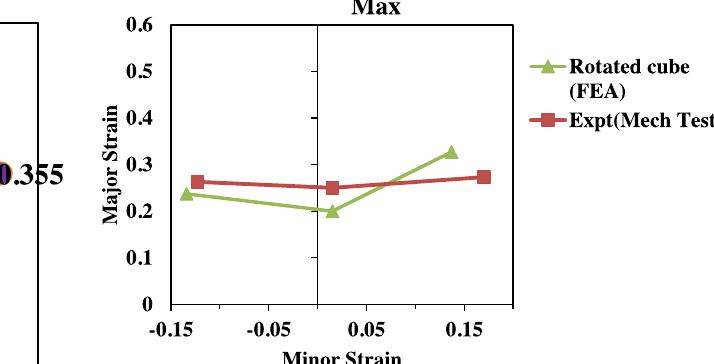
Fig. 21. Comparison of numerical and experimental failure limit curves for rotated